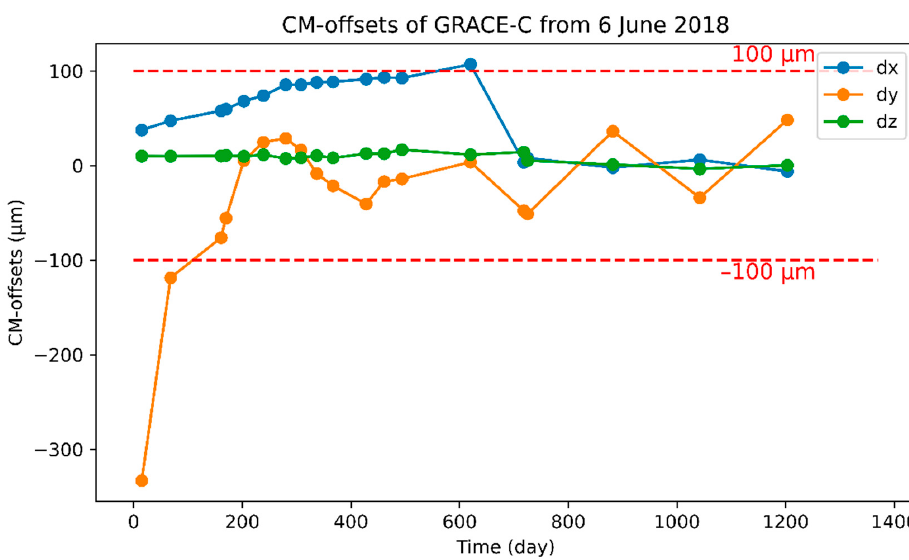
Figure 12. Estimation of CM-offset of GRACE-C.